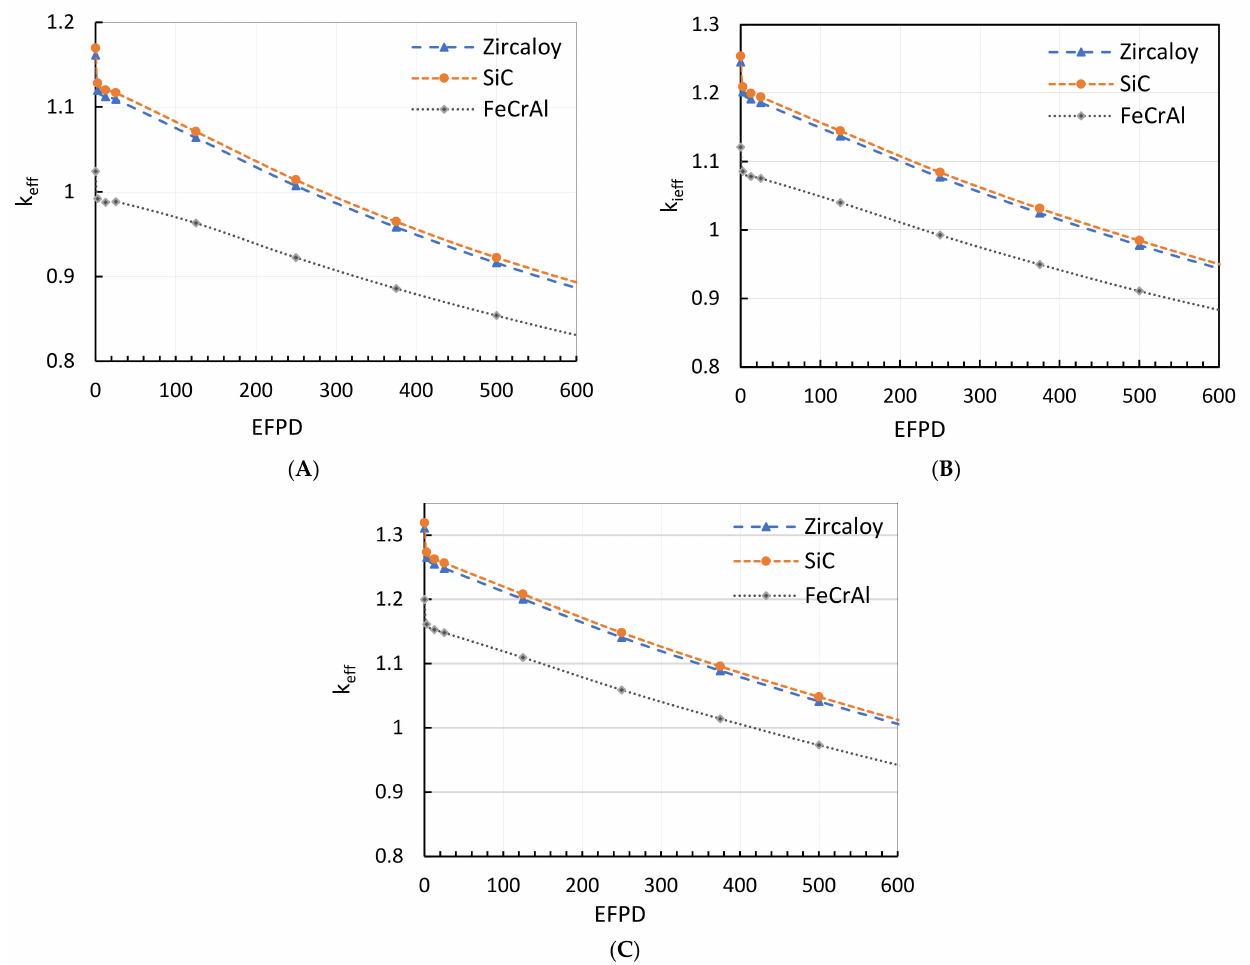
Figure 6. Unit cell effective multiplication factor versus EFPDs for the three cladding materials with different enrichments ( A ) 1.68 wt % ( B ) 2.64 wt %( C ) 3.14 wt